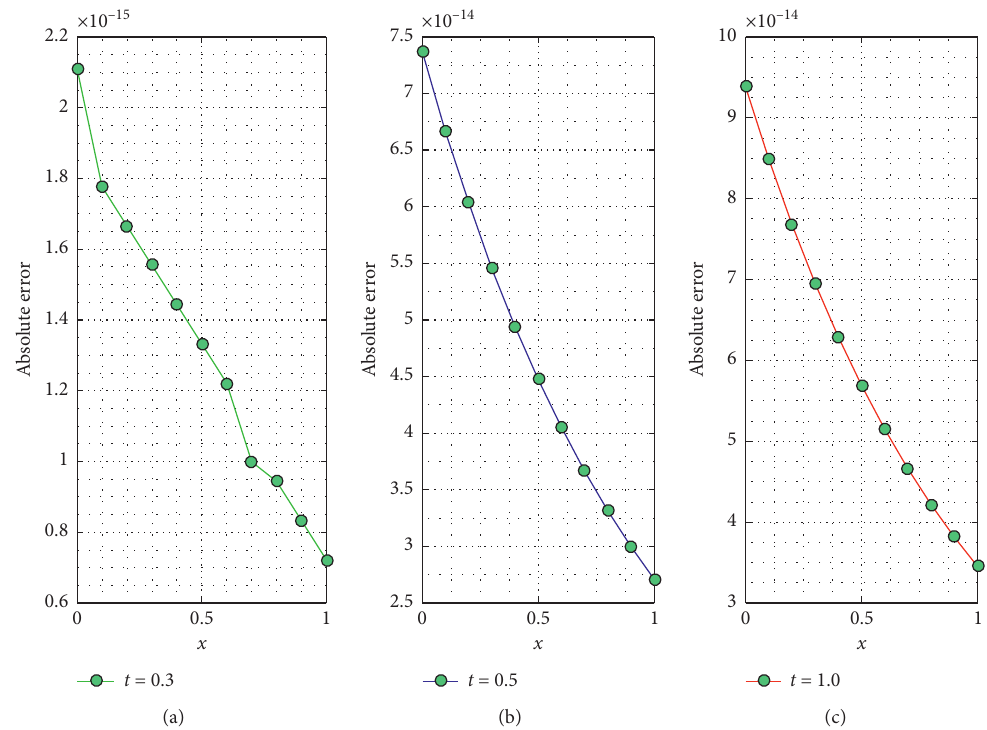
Figure 5: Comparison in terms of absolute errors for various values of t for Test Problem